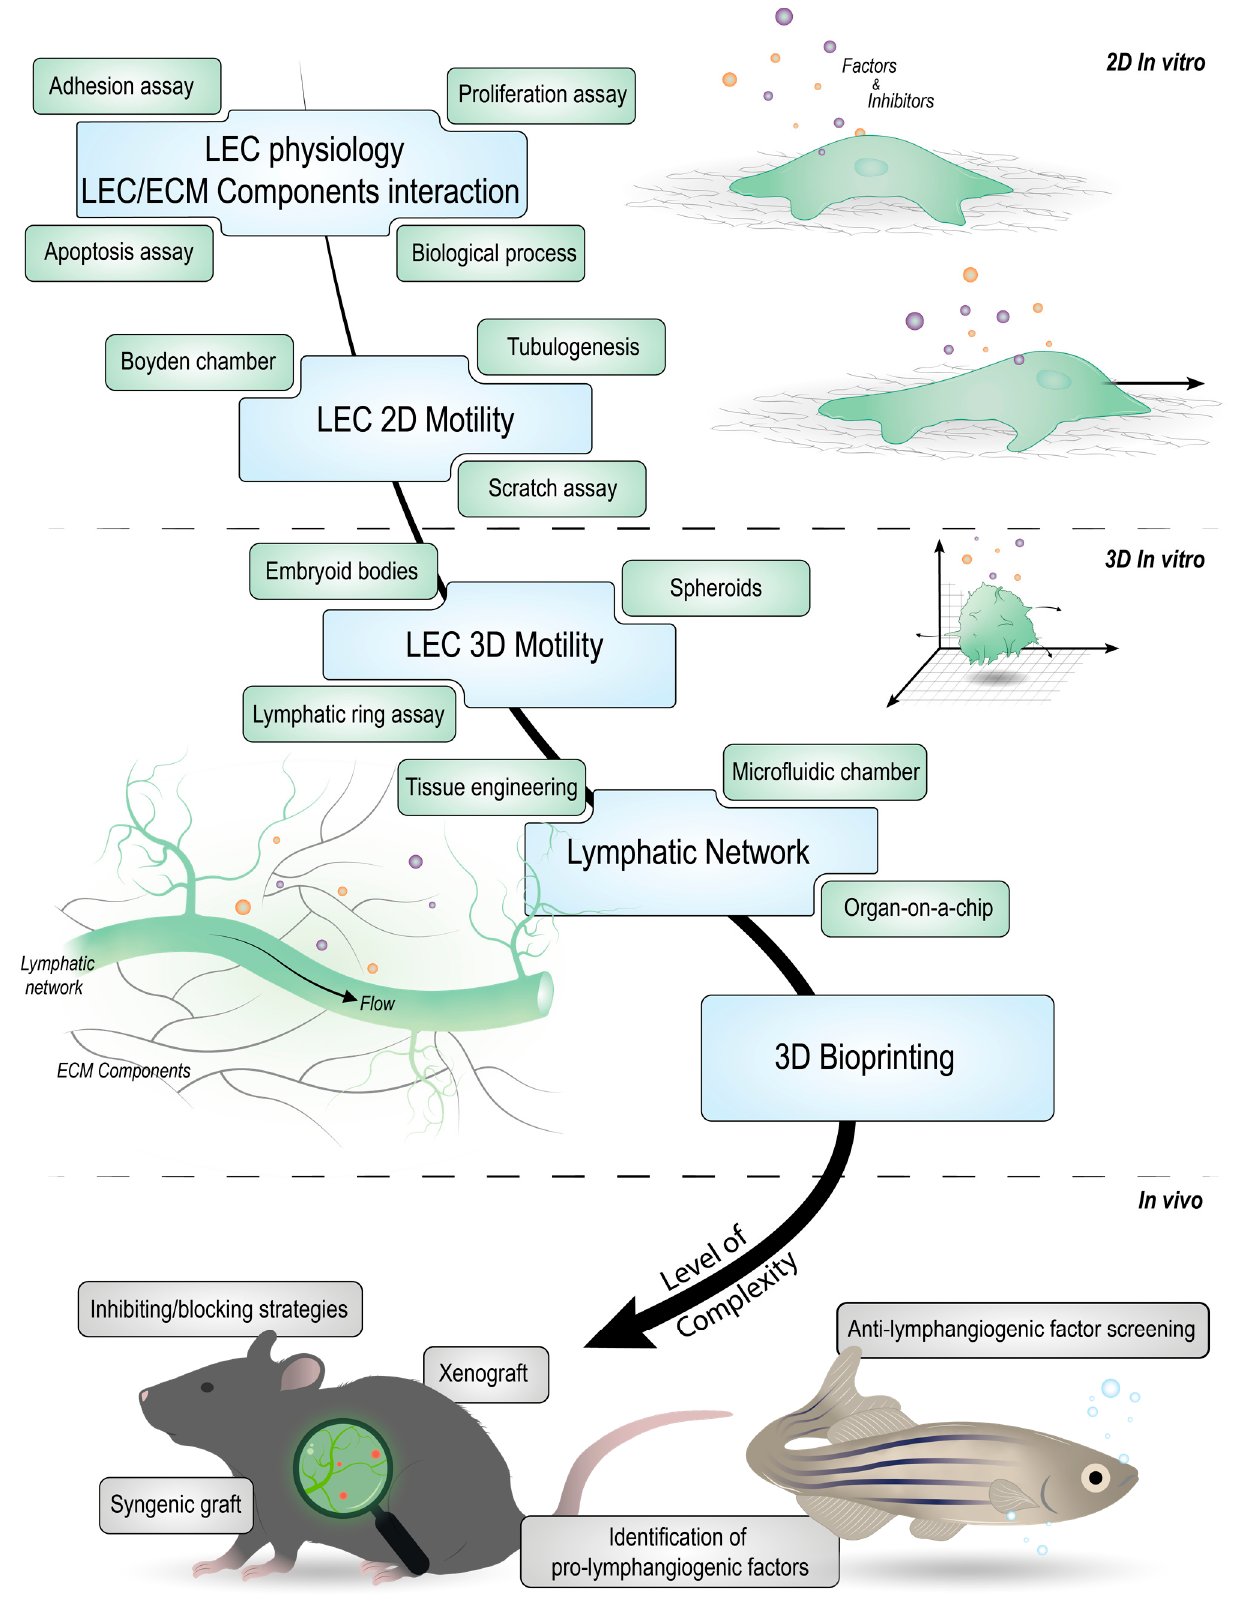
Figure 2. Summary of the in vitro and in vivo lymphangiogenesis (LA) assays according to their level of complexity. The first level of complexity refers to 2D in vitro cultures of isolated LECs and is used for investigating any individual step of the lymphangiogenic process (proliferation, migra- tion, invasion, etc.) and morphogenesis. Three-dimensional in vitro static cultures increase the level